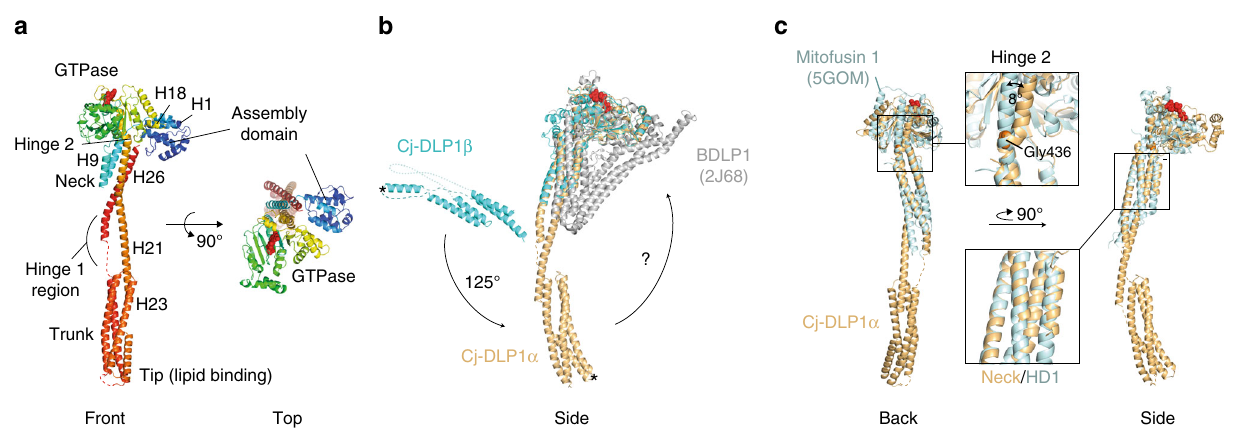
Fig. 4 Structural analysis of Cj-DLP1 bound to GDP·AlF 4 ¯. a Cartoon of Cj-DLP1 monomer showing a BDLP1-like fold augmented with an N-terminal globular assembly domain (Cj-DLP1 AD ). Like BDLP1, Cj-DLP1 has a distinct highly fl exible hinge 1 region. Here, hinge 1 and hinge 2 are in the open conformation. b